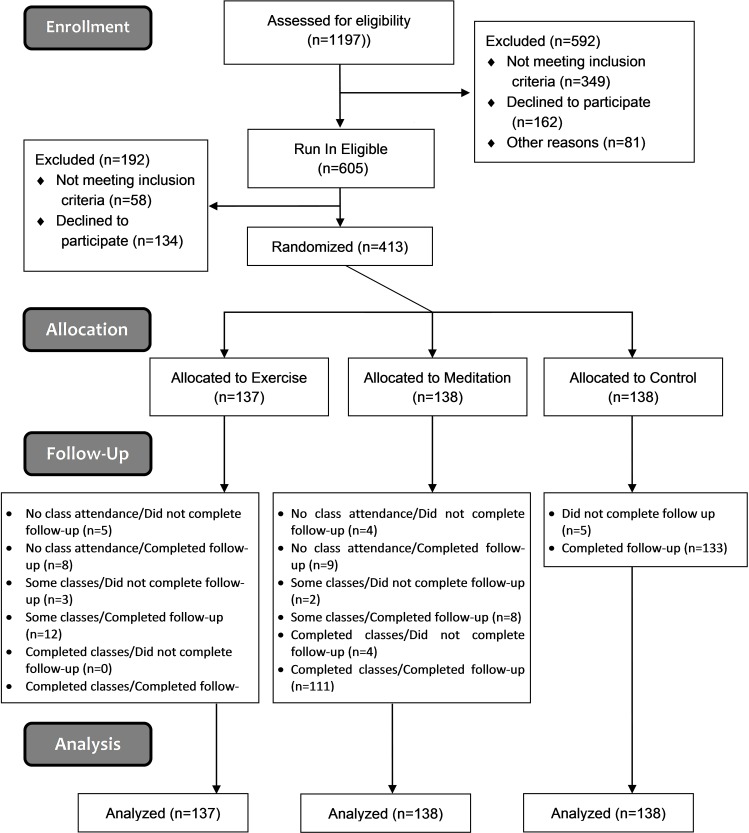
Primary intention-to-treat efficacy analyses includes all participants (n = 413).